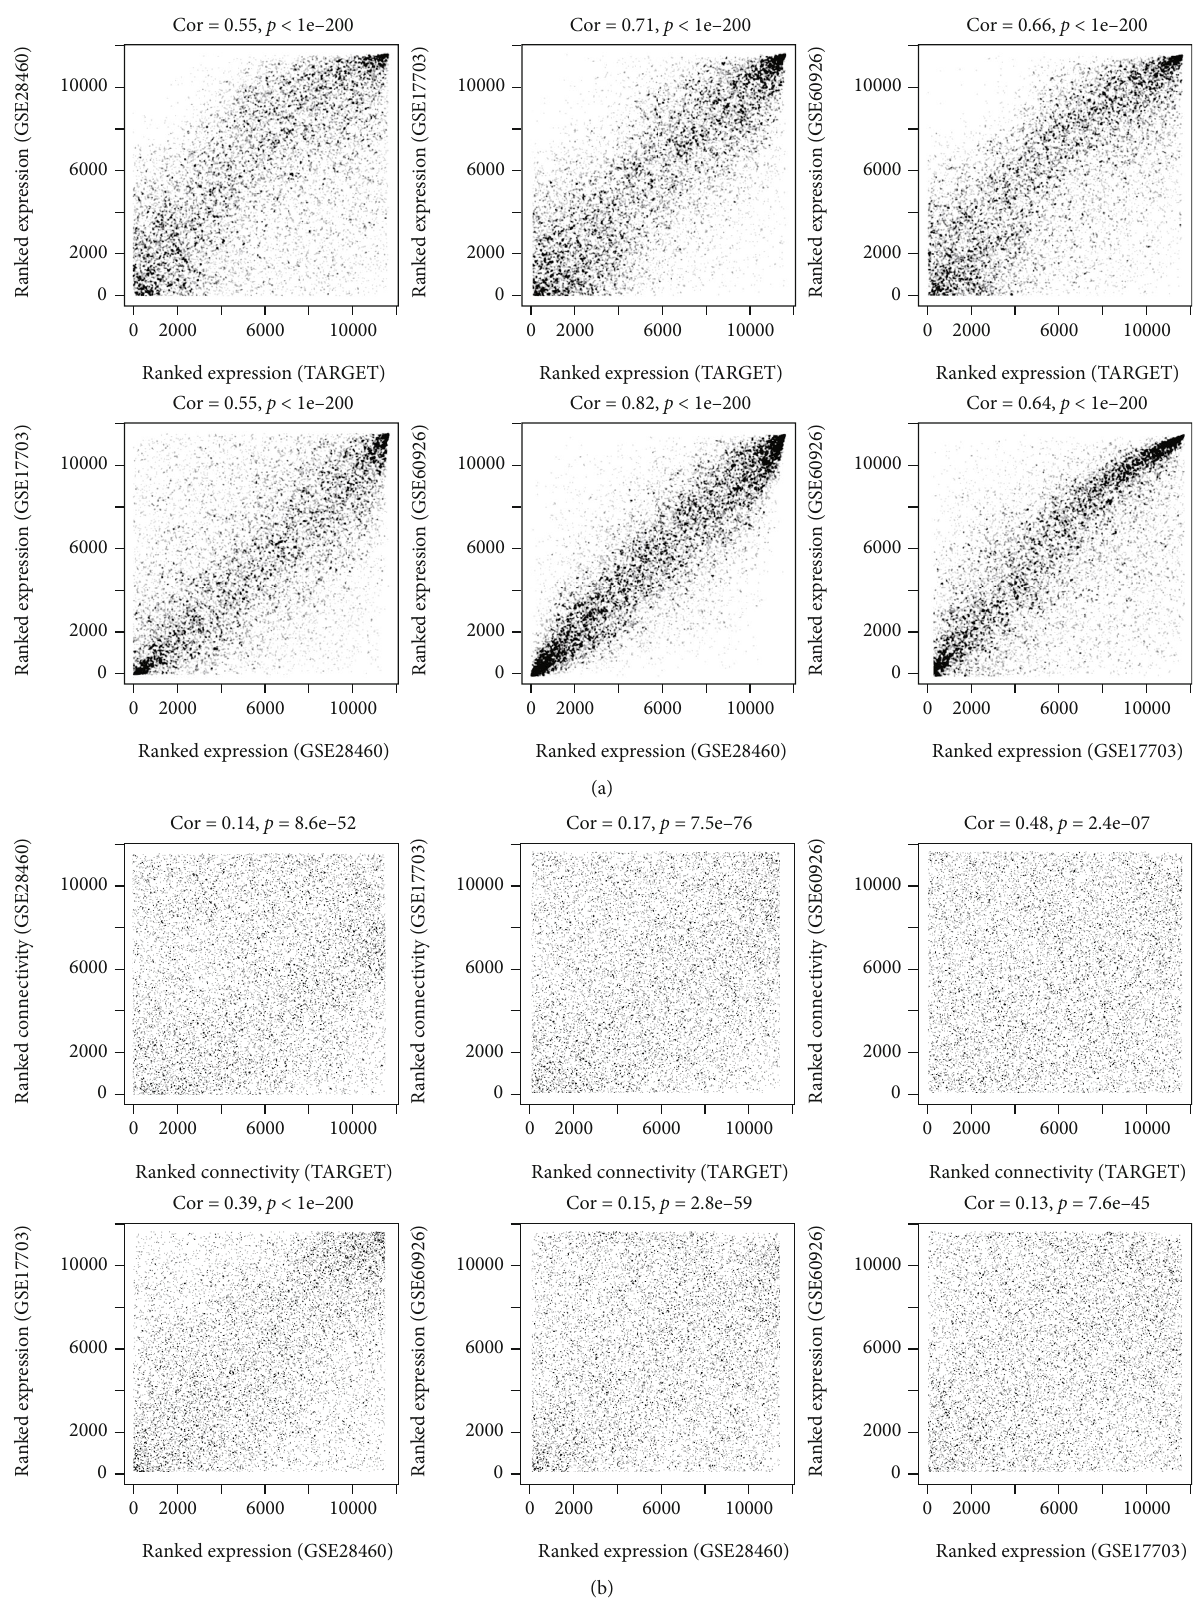
Figure 1: The correlation between any two datasets (TARGET, GSE60926, GSE28460, and GSE17703) in the RNA expression levels (a) and connectivity